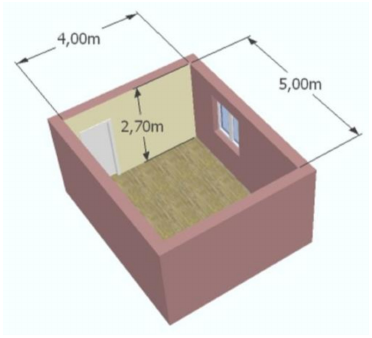
Figure 1. The test room. NB: all the figures use dots and commas as per Italian